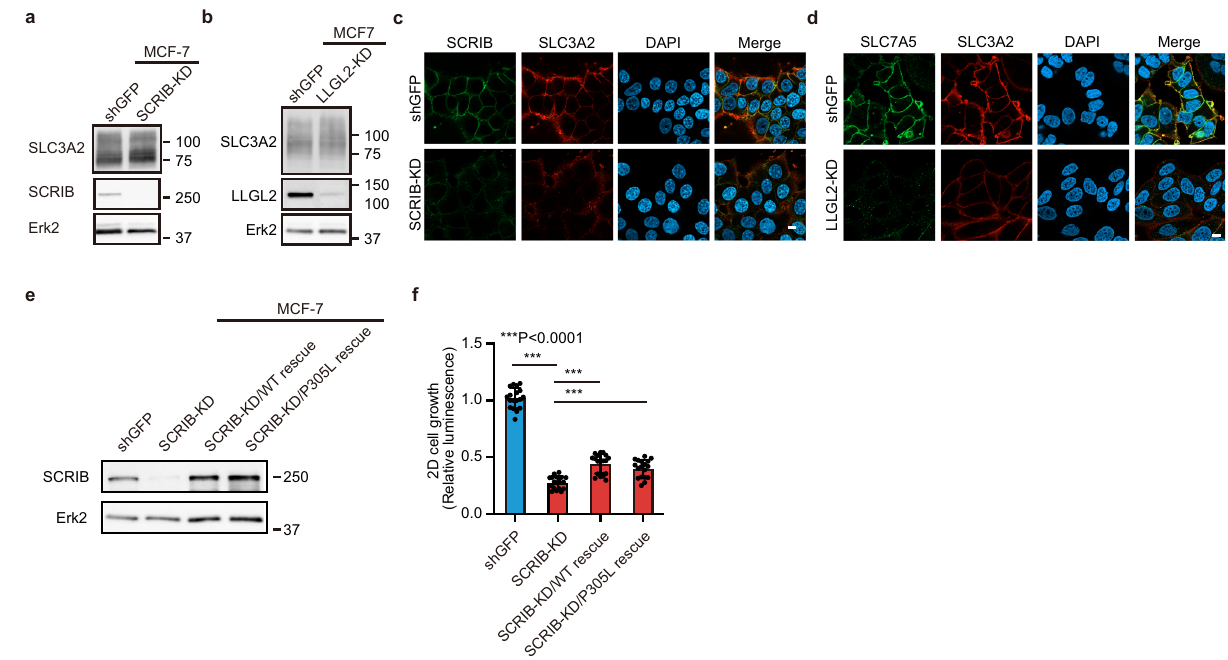
Fig. 3 SCRIB regulates membrane localization of SLC3A2 in ER + breast cancer cells. a Total protein level of SLC3A2 in SCRIB-KD MCF-7 cells. b Total protein level of SLC3A2 in LLGL2-KD MCF-7 cells. c Immunostaining images of SCRIB and SLC3A2 in MCF-7 cells. Scale bar; 10 µ m. d Immunostaining images of SLC7A5 and SLC3A2 in LLGL2-KD MCF-7 cells. Scale bar; 10 µ m. e Rescue of SCRIB expression in SCRIB-KD MCF-7 cells. f 2D growth of SCRIB- KD rescued MCF-7 cells. Data in ( f ) are shown as mean ± s.e.m.; n = 18 from six biological replicates performed in triplicate. Statistical analysis was conducted by one-way ANOVA followed by Tukey ’ s